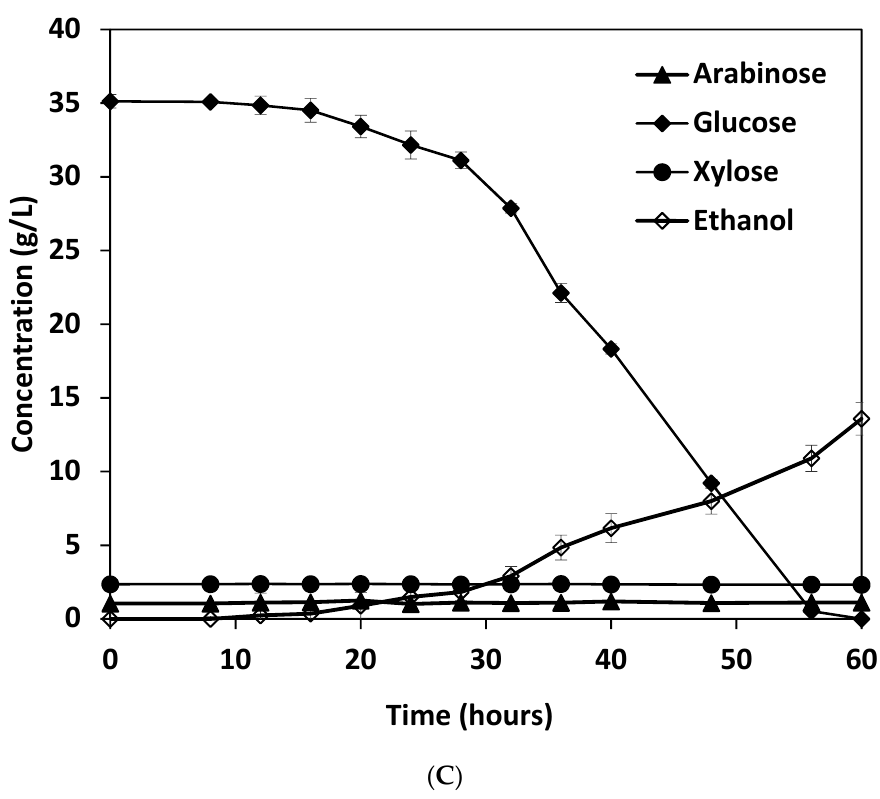
Figure 2. Pre-treatment of Miscanthus and the fermentation profile of Miscanthus hydrolysate. ( A ) Xylose and glucose concentrations of Miscanthus cultivars following an acid pre-treatment; ( B ) cellulose hydrolysis yield of Miscanthus cultivars following saccharification (% of theoretical yield). ( C ) Fermentation profile of S. cerevisiae NCYC2592 on a hydrolysate derived from Miscanthus cultivar B (BE04). Data representative of triplicate values.